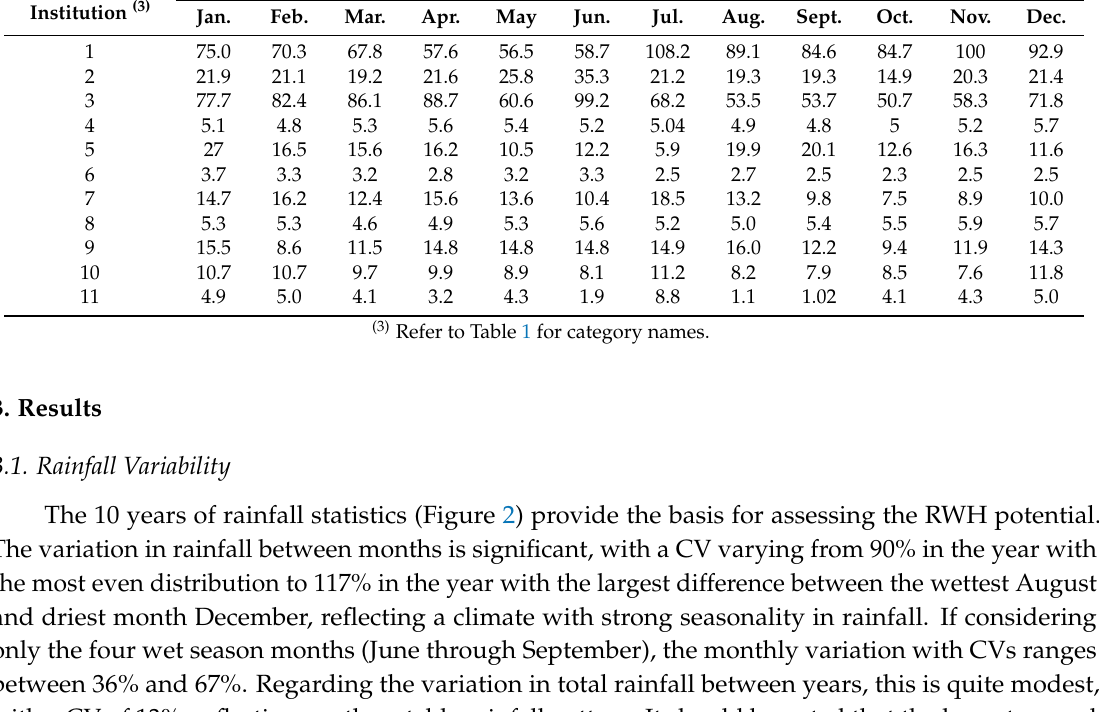
Table 4. Summary of the monthly water consumption data of targeted large public institutions. Category of Institution